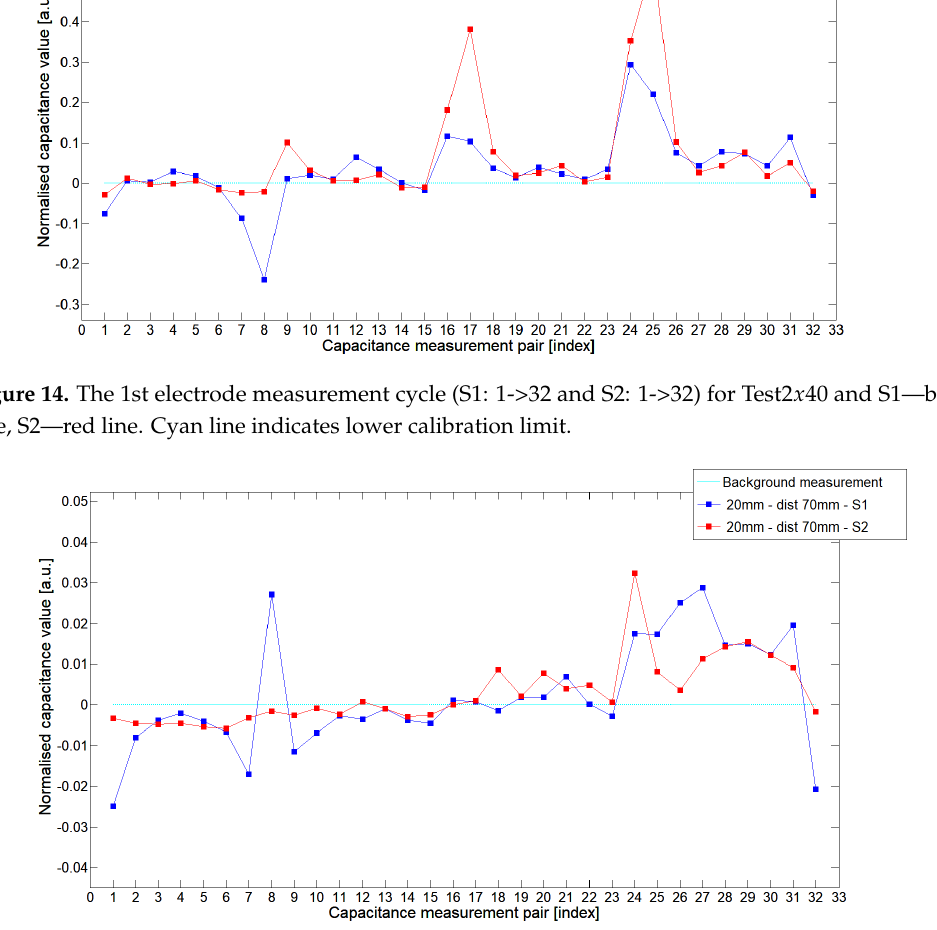
Figure 15. The 1st electrode measurement cycle (S1: 1->32 and S2: 1->32) for Test20 P 1 and S1—blue line, S2—red line. Cyan line indicates lower calibration limit.